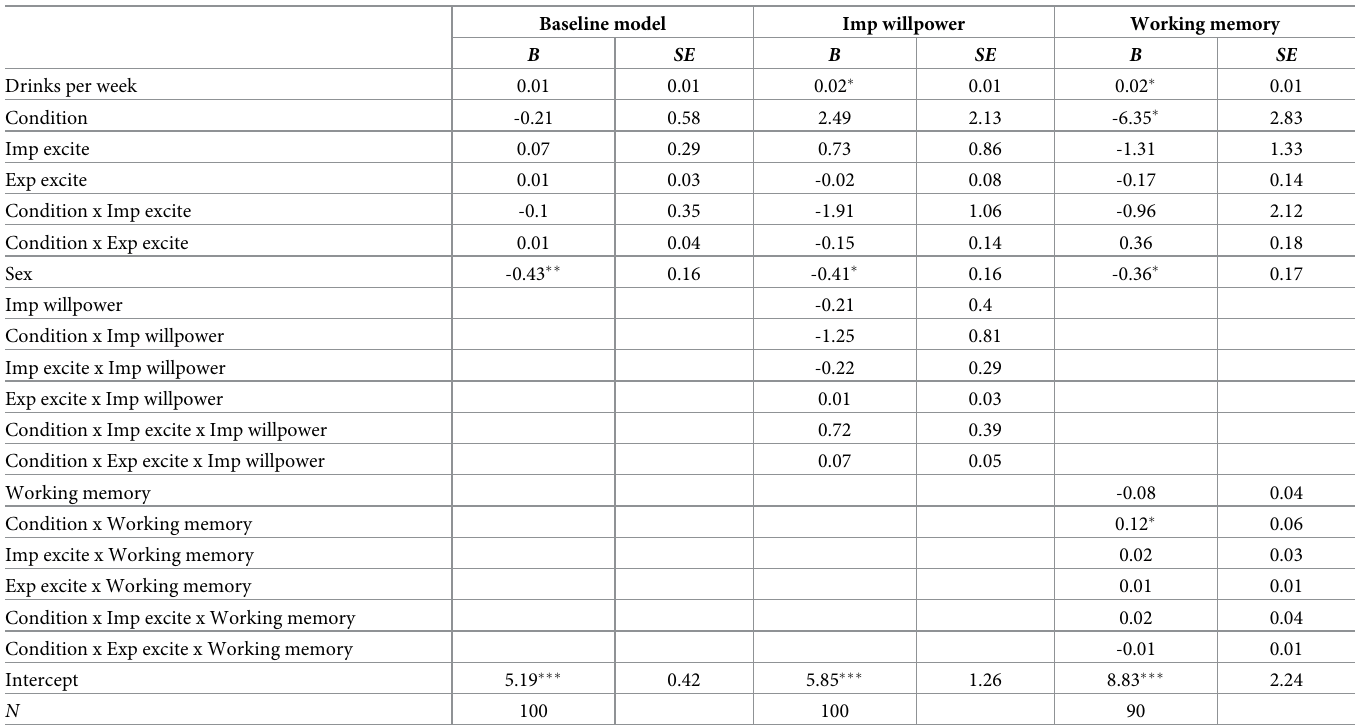
Table 5. Alcohol excite